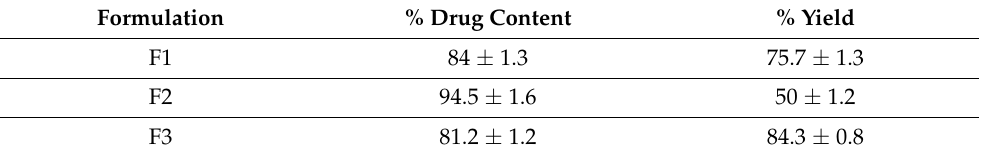
Table 2. Drug content and percent yield of MTX loaded AEM-CS NPs in mean ± S.D. ( n = 3).